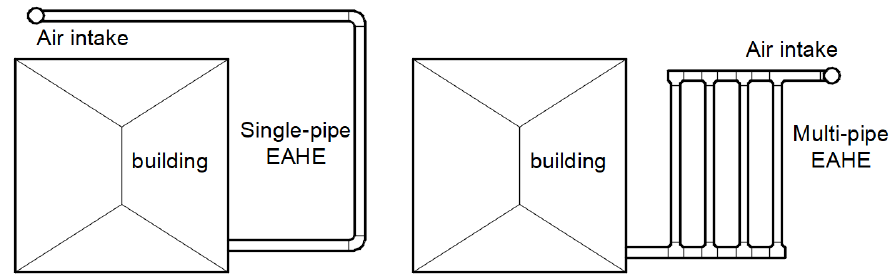
Figure 1. Top view of exemplary single-pipe and multipipe